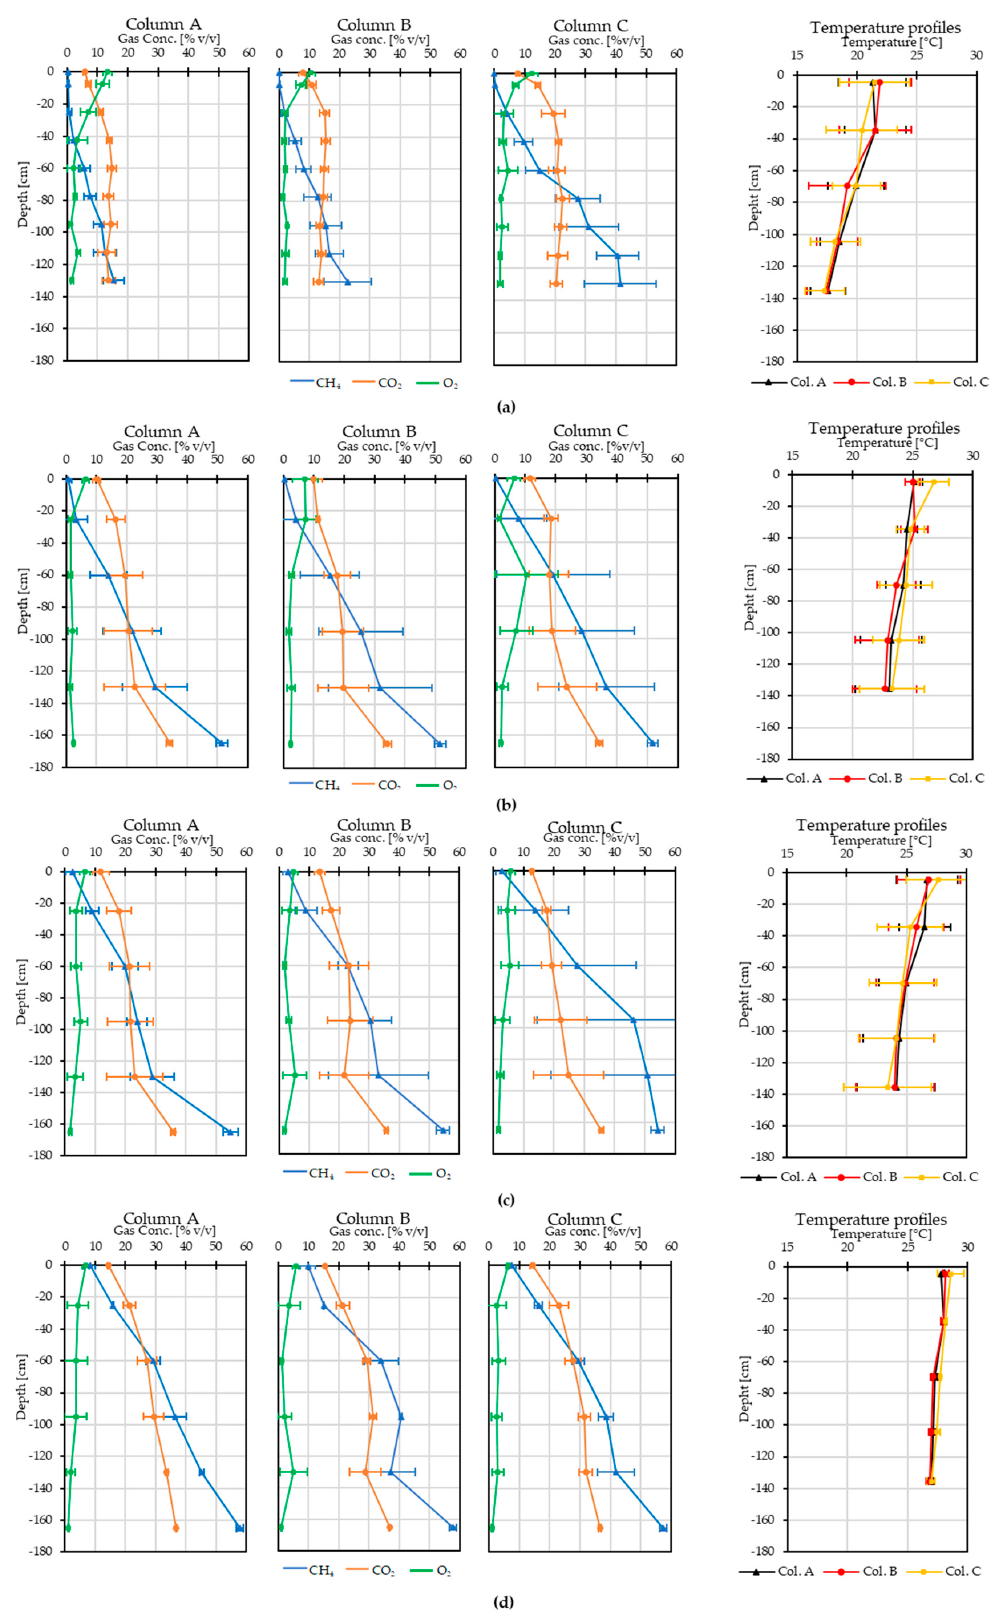
Figure 2. Average gas concentrations and temperature profiles. CH 4 Load Range: ( a ) 0–100 g CH 4 m − 2 d − 1 , ( b ) 100–200 g CH 4 m − 2 d − 1 , ( c ) 200–300 g CH 4 m − 2 d − 1 , ( d ) > 300 g CH 4 m − 2 d − 1